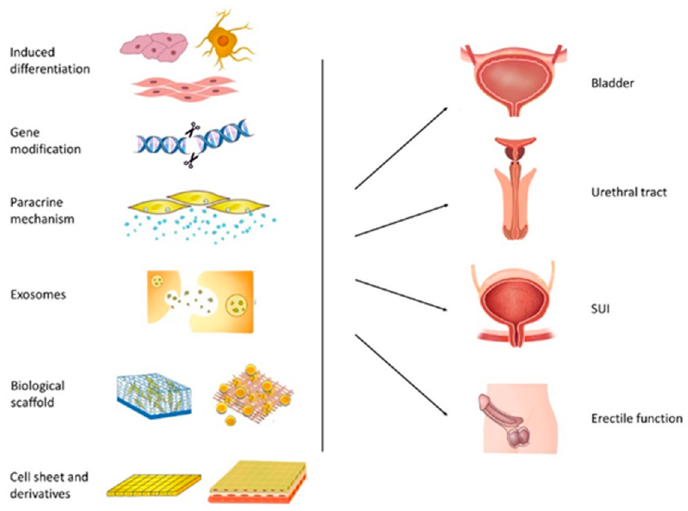
Figure 2. Approaches to enhance ASC therapeutic performance for lower urinary tract dysfunction.